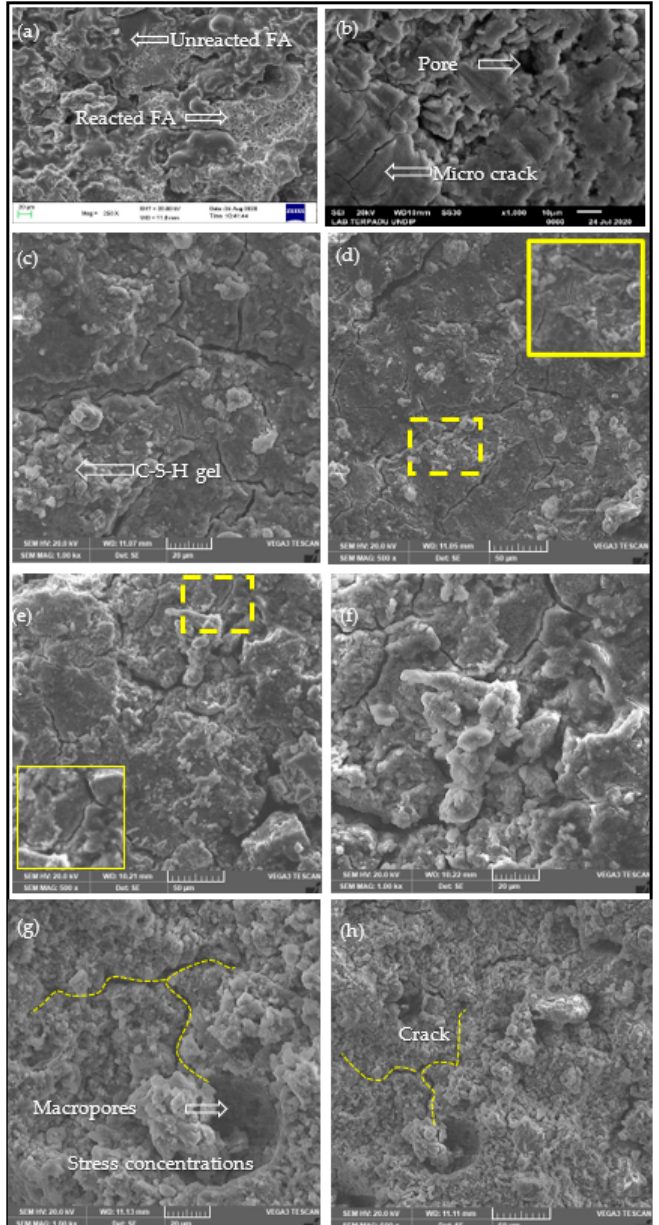
Figure 9. SEM images of geopolymer paste with various nanosilica content: ( a , b ) 0 wt%, ( c , d ) 2 wt%, ( e , f ) 3 wt%, ( g , h ) 4 wt%.